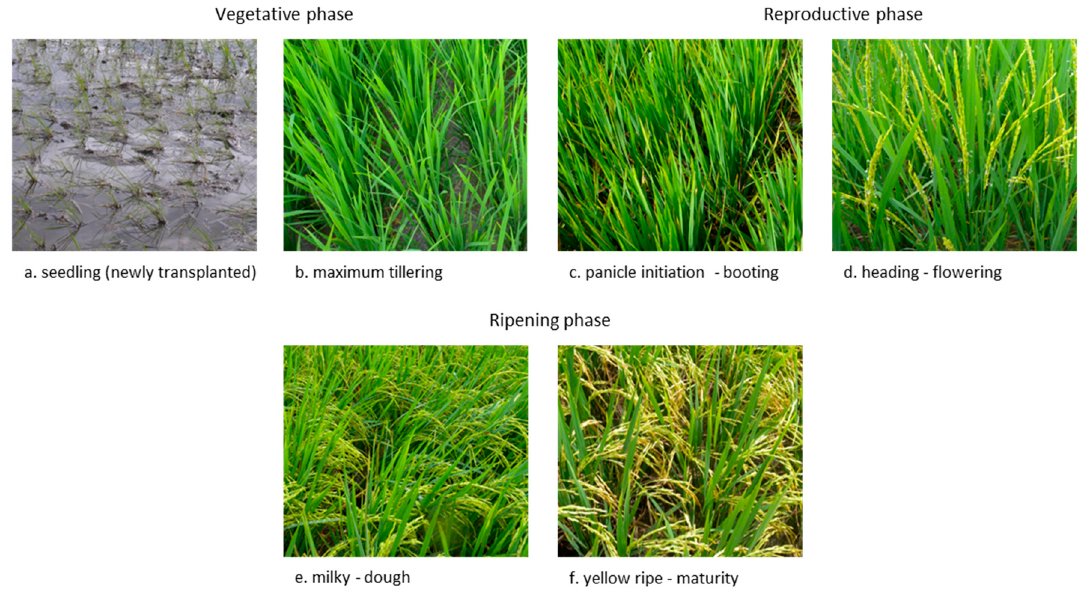
Figure 2. Photos depicting the general appearance of rice crop at di ff erent rice crop growth stages during the 2013 wet season (WS).